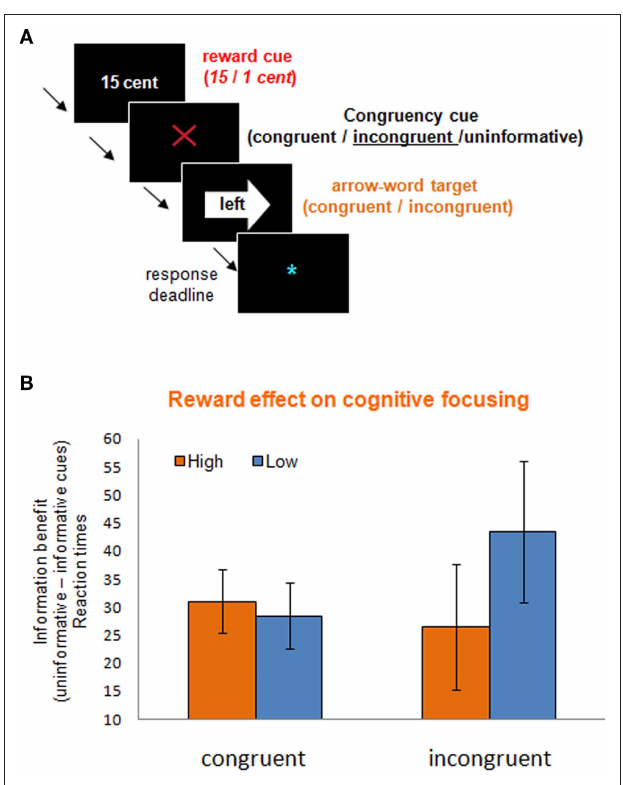
Figure 3 | incentive motivation might have detrimental effects on cognitive focusing. (A) The rewarded Stroop paradigm, including a reward cue (1 or 15 cent), an information cue about the upcoming target congruency [informative: incongruent (this example) or congruent (green circle); or uninformative (gray question mark)], and an arrow-word Stroop target. The task was to respond to the direction indicated by the word. (B) Reward anticipation had opposite effects on widening and focusing of attention as measured with the information benefit (uninformed–informed) on congruent and incongruent targets respectively; with high anticipated reward particularly impairing proactive focusing on the incongruent trials (M. van